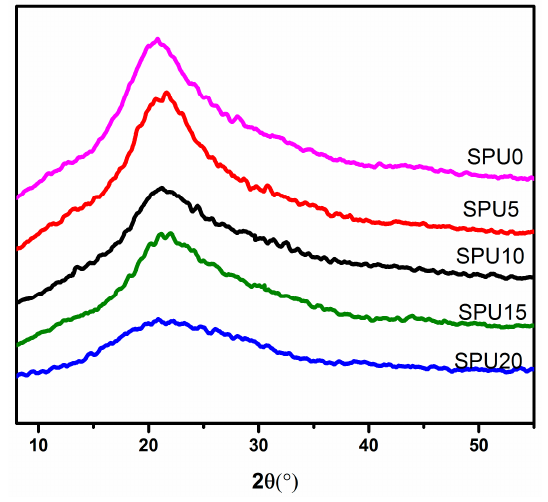
Figure 9. X-ray diffractograms of SPU films containing different HDI-T contents.